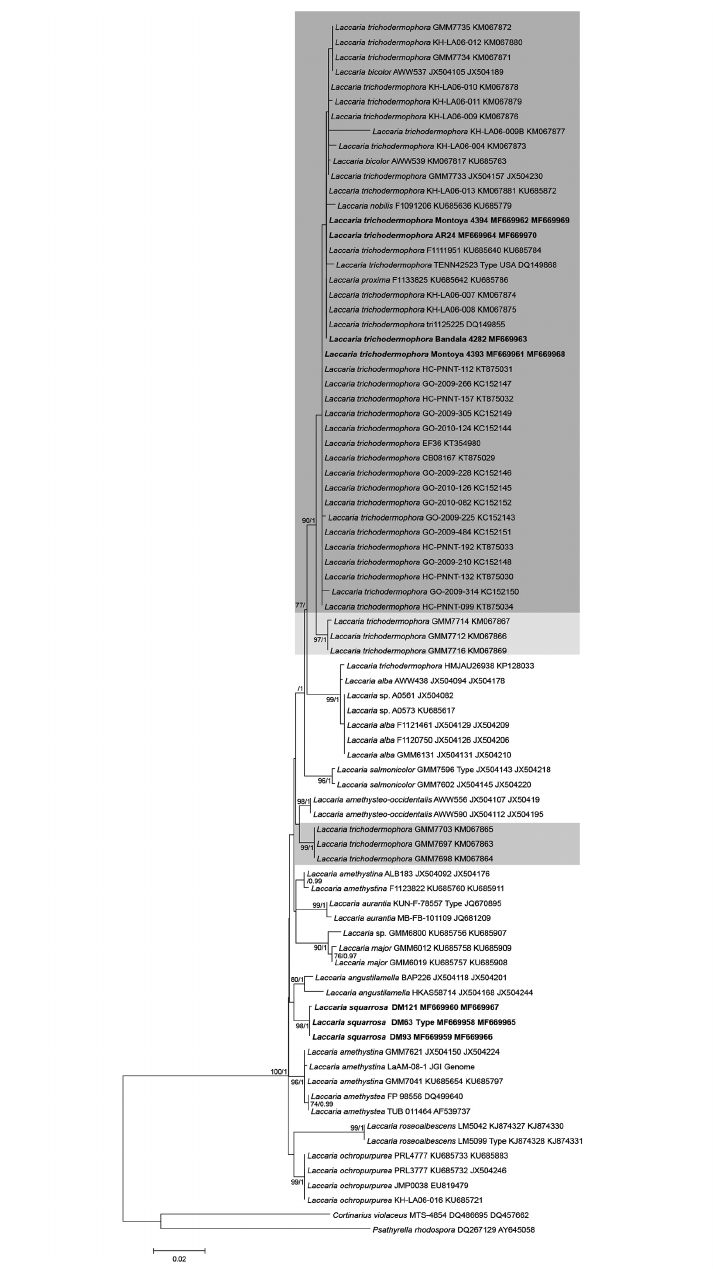
Figure 1. Phylogenetic relationships within Laccaria species inferred from the combined ITS and LSU se- quence data by maximum likelihood method. Tree with the highest log likelihood (–4163.7219), the percent- age of trees in which the associated taxa clustered together (only values ≥ 70% are considered) is shown next to the branches, followed by the posterior probabilities (only values ≥ 0.90 are indicated) obtained after Bayesian inference. The tree is drawn to scale, with branch lengths measured in the number of substitutions per